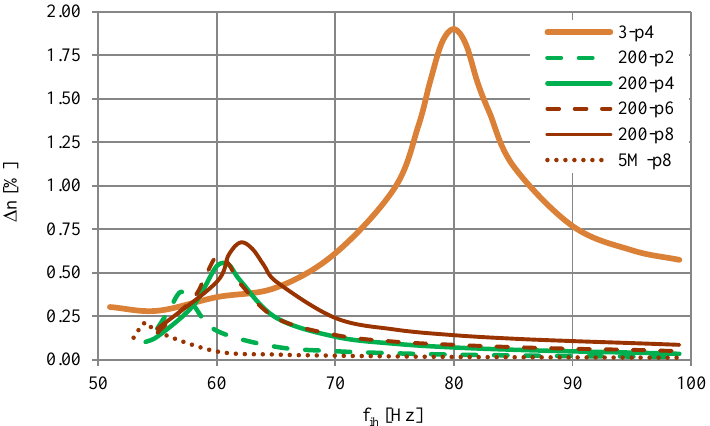
Figure 10. Computed amplitude of speed fluctuation (related to rated speed) vs. the frequency of voltage interharmonics for the various motors and the case of NMI.